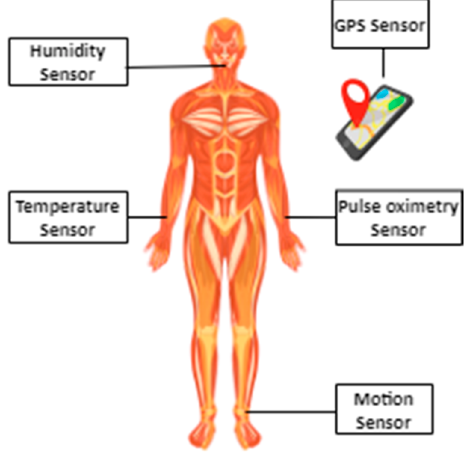
Figure 3. The wearable sensors’ locations on the human body .